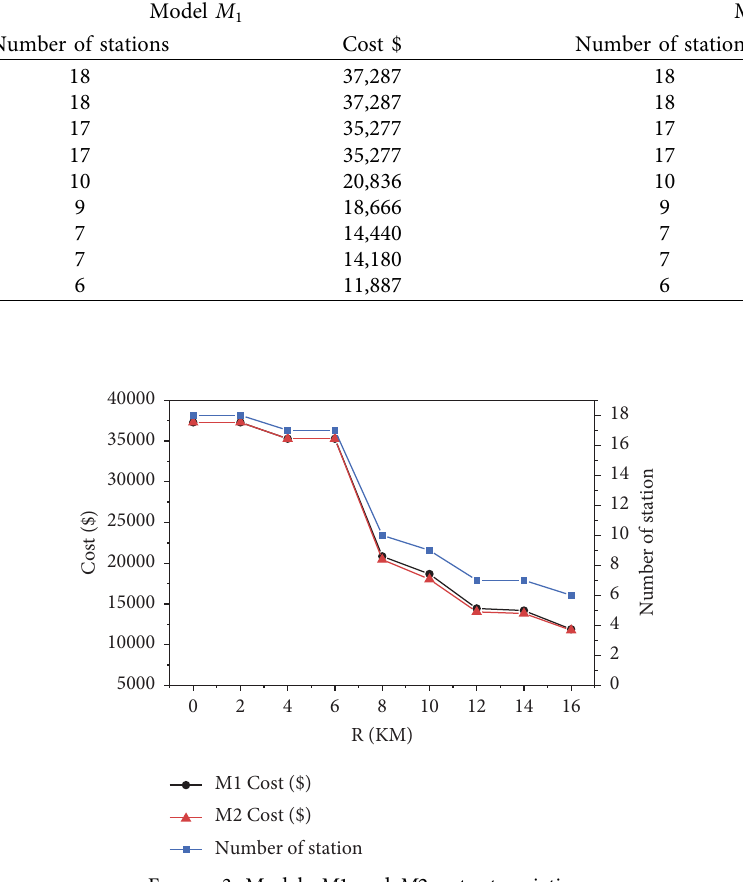
Figure 3: Models M 1 and M 2 output